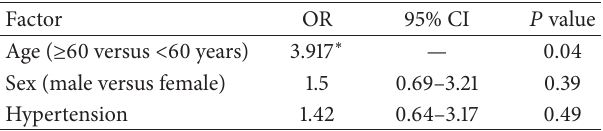
Table 2: Univariate analysis of risk factors associated with periph- eral arterial disease in adults of 40 years of age and older, General Hospital of Huambo, Angola, 2015 ( 𝑛 = 115 ).